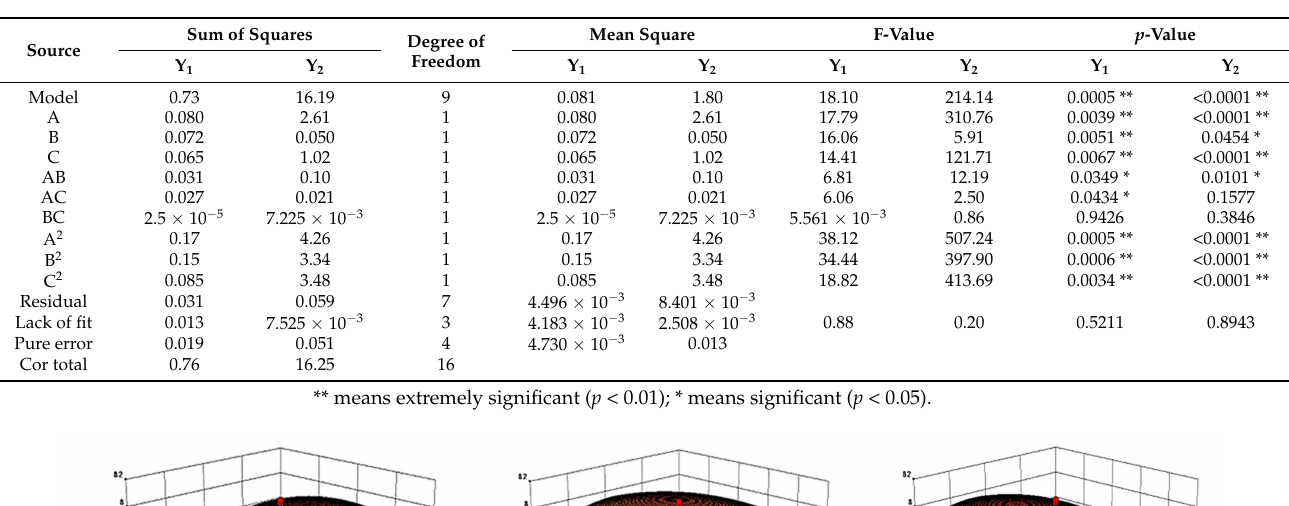
Table 3. The result of the variance analysis.